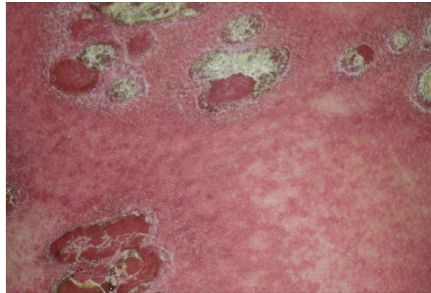
Figure 3: Closer view to psoriasis plaques, erythematous rash, and tiny pustuloses.